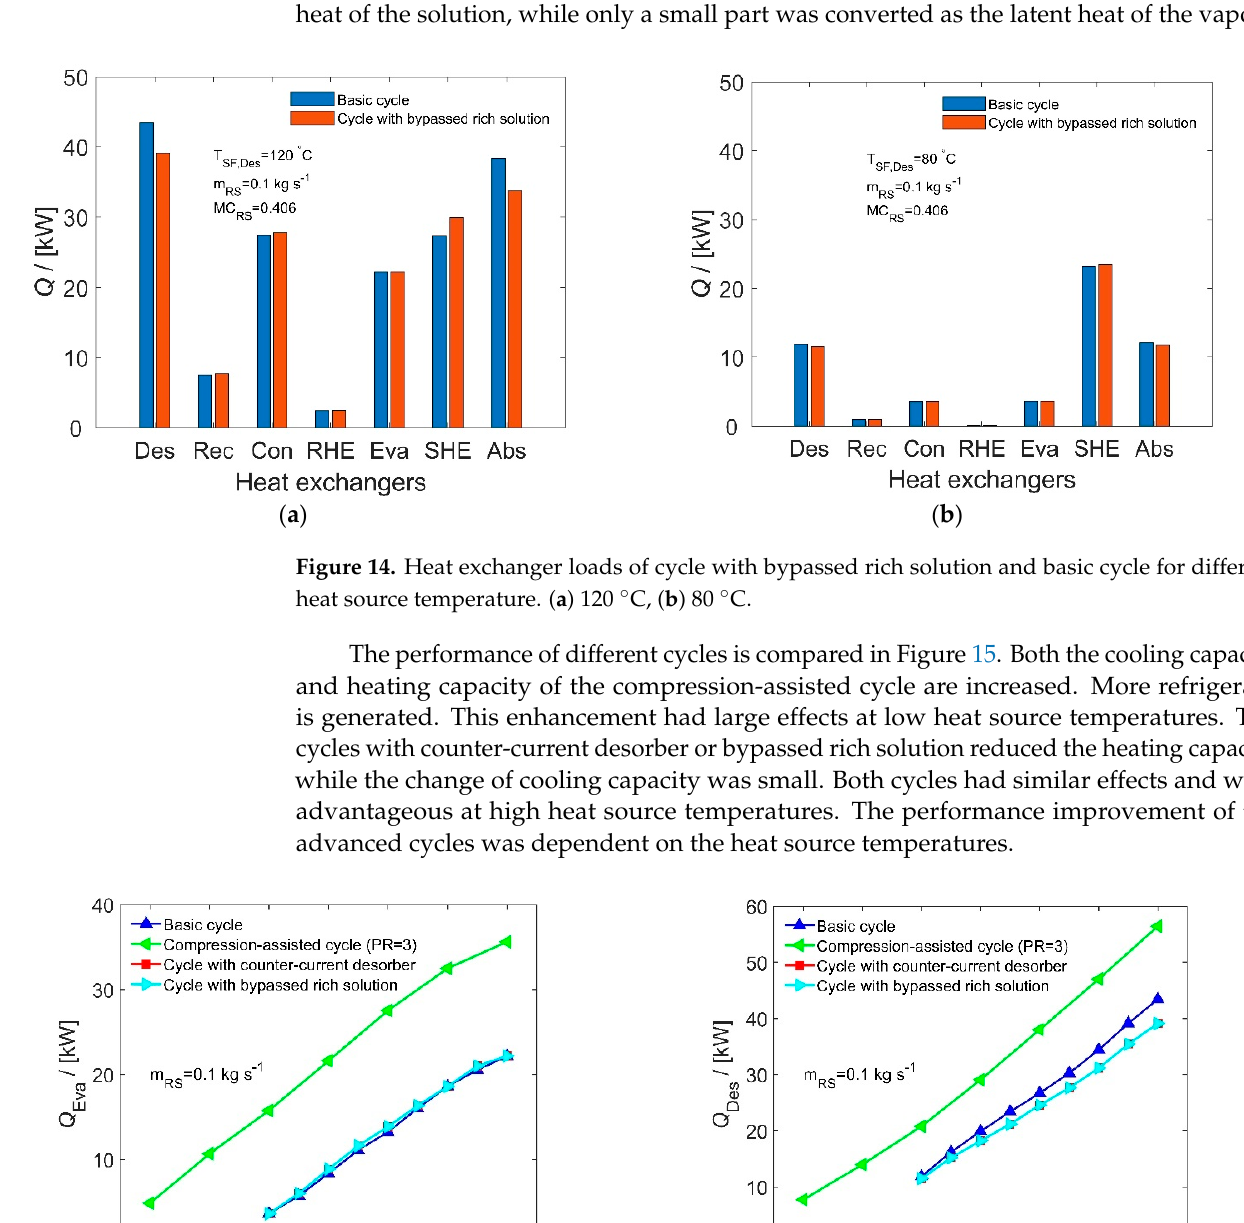
Figure 13. Performances of cycle with bypassed rich solution and basic cycle as a function of heat source temperature. Cycle performances are ( a ) COP, ( b ) Solution circulation ratio.